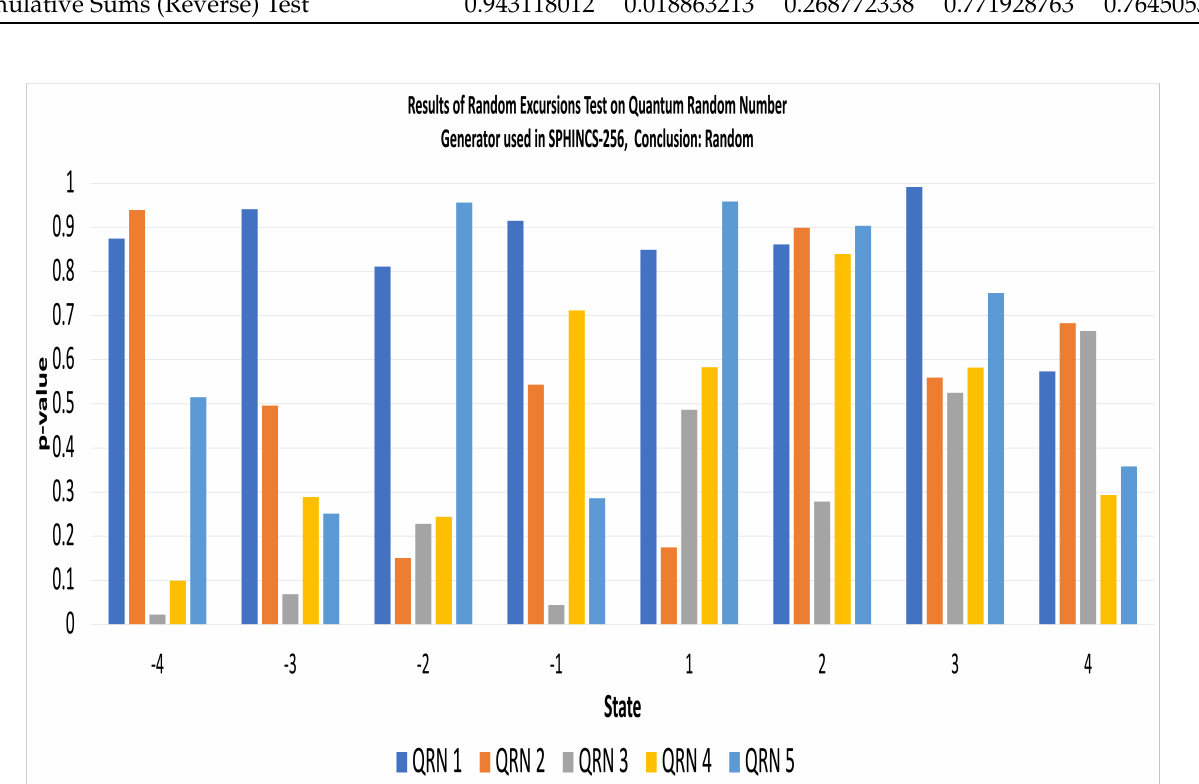
Figure 17. Results of Random Excursions Test on Quantum Random Number Generator(QRNG) used in